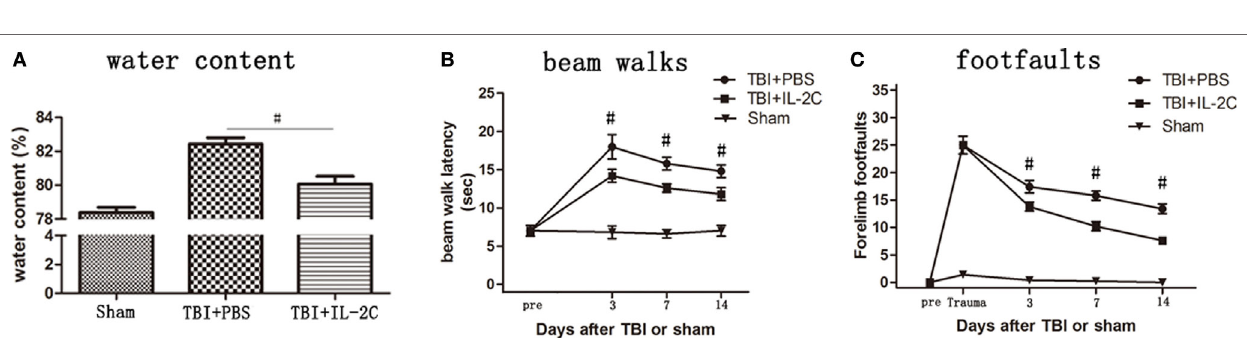
FigUre 5 | (a) On day 3 after traumatic brain injury (TBI), mononuclear cells were isolated from the brain using discontinuous Percoll gradients, and flow cytometry analysis was used to detect the percentage of Tregs within the CD4 + population. (B) Treatment with IL-2C significantly increased the number of Tregs in the central nervous system on day 3 post-injury. Data are presented as the mean ± SD; * p < 0.05 and # p < 0.01 ( n = 5 mice/group).